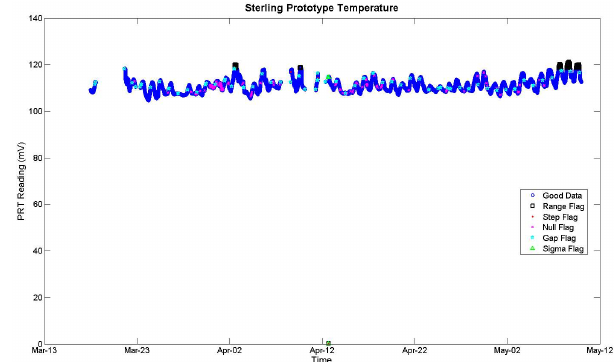
Fig. 10. Time series of platinum resistance thermometer (PRT) ob- servations in March–May 2011 from Domain 10: North Sterling, Colorado, but data that have failed QC tests are flagged as suspect. The different colored symbols represent the different flags that have been applied by the automated plausibility